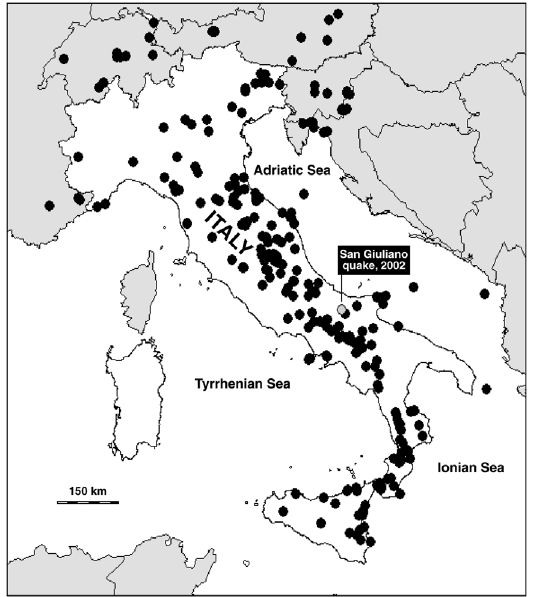
Fig. 2. Events with I ≥ VIII MCS from the catalogue of Italian damaging earthquakes (CPTI catalogue, Boschi et al. , 1999) with the location of the San Giuliano event. Circle radius is the 75 percentile of the CPND distri- bution (see text for